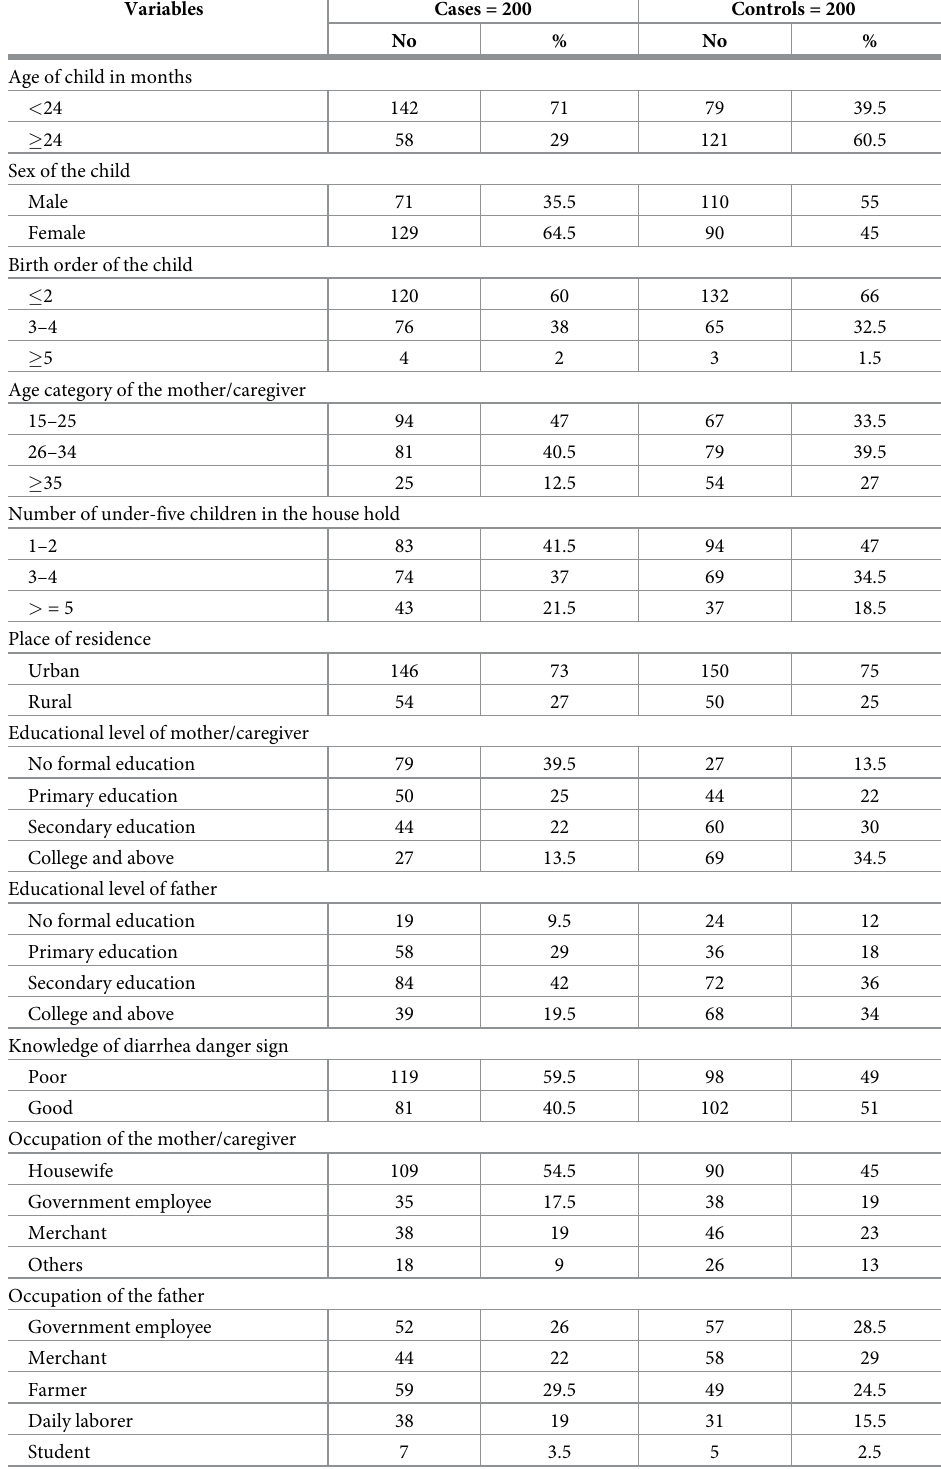
Table 1. Predisposing factors of delay in seeking care among mothers/caregivers of < 5 children with diarrheal diseases in public health facilities of Arba Minch town, south Ethiopia, 2019 (n =